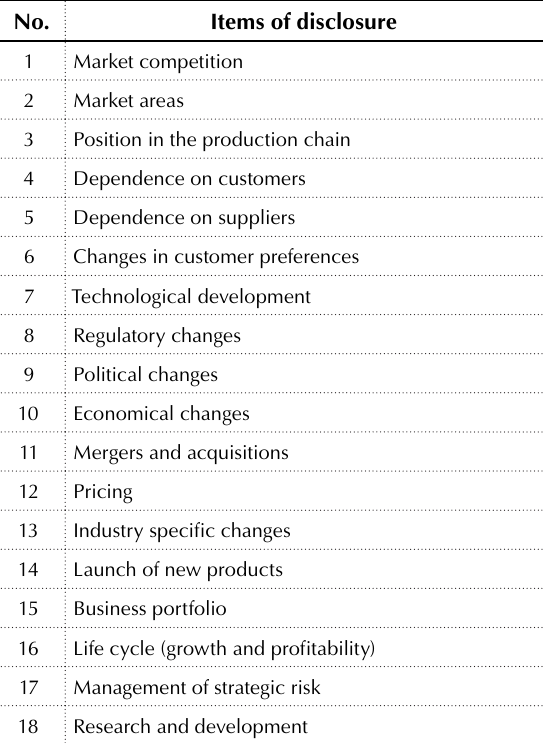
Table 2. Strategic risk disclosure